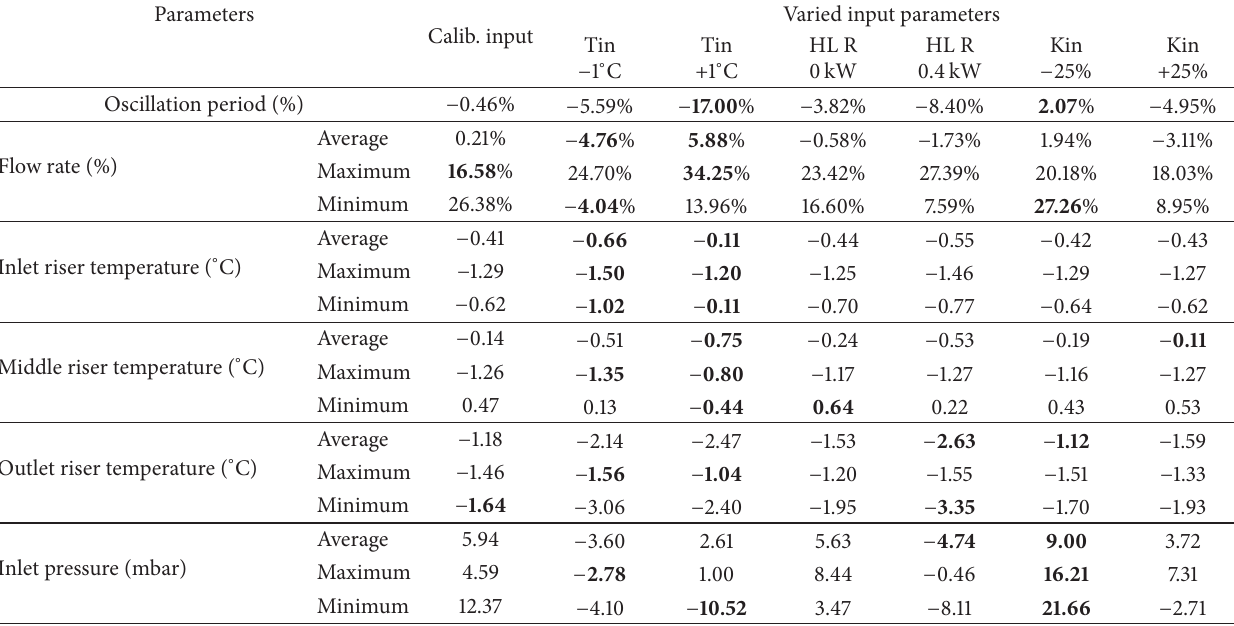
Table 6: Difference between calculated and experimental values, test